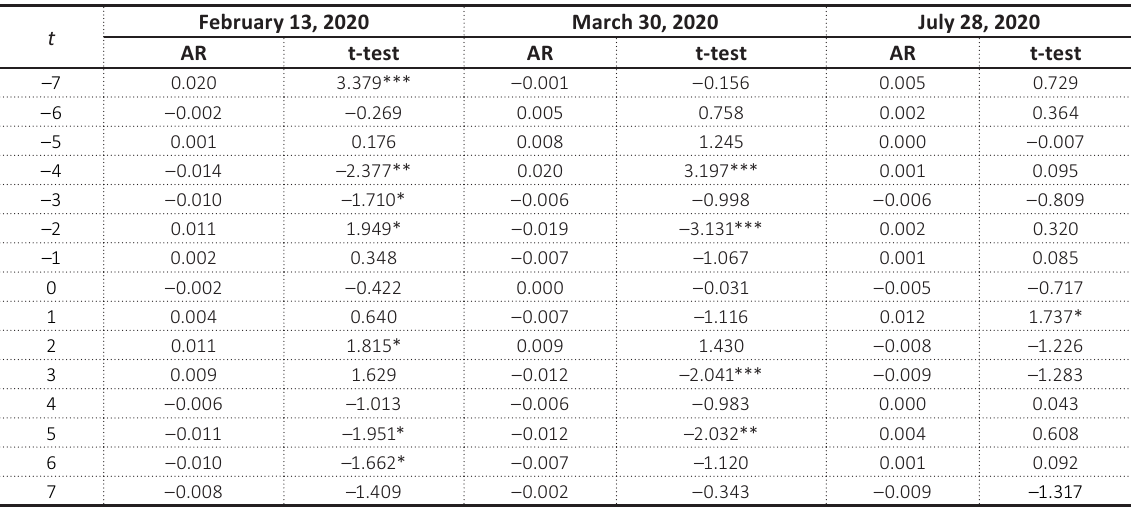
Table 1. Abnormal profit (AR) and t-test results for three lockdown times due to COVID-19 in